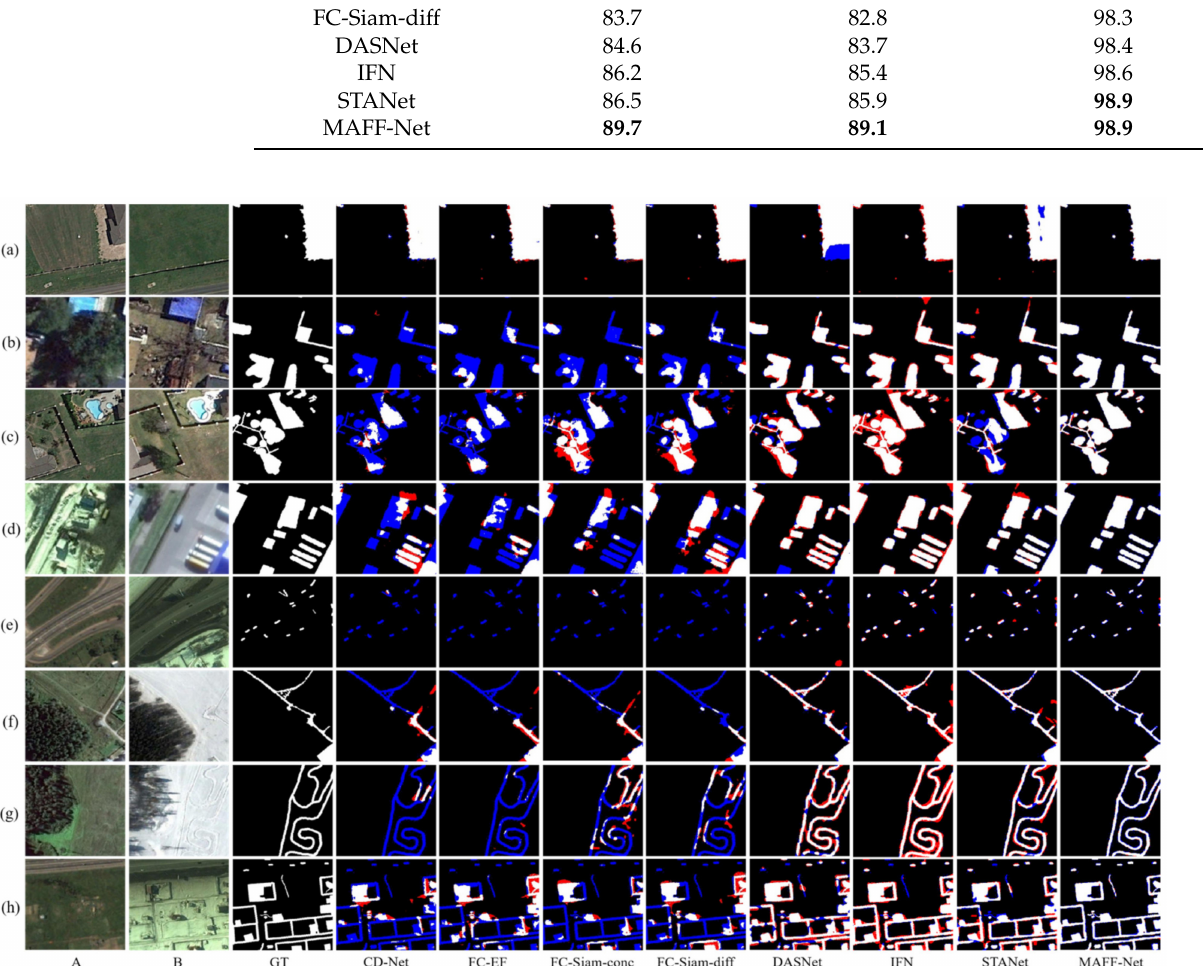
Figure 8. Illustration of a qualitative comparison on dataset CDD. ( a – h ) indicate samples from CDD and the change maps obtained with different methods. The white color indicates the changes that were correctly detected. Black indicates that no changes have been correctly detected. Red indicates false alarms. Blue indicates unpredicted